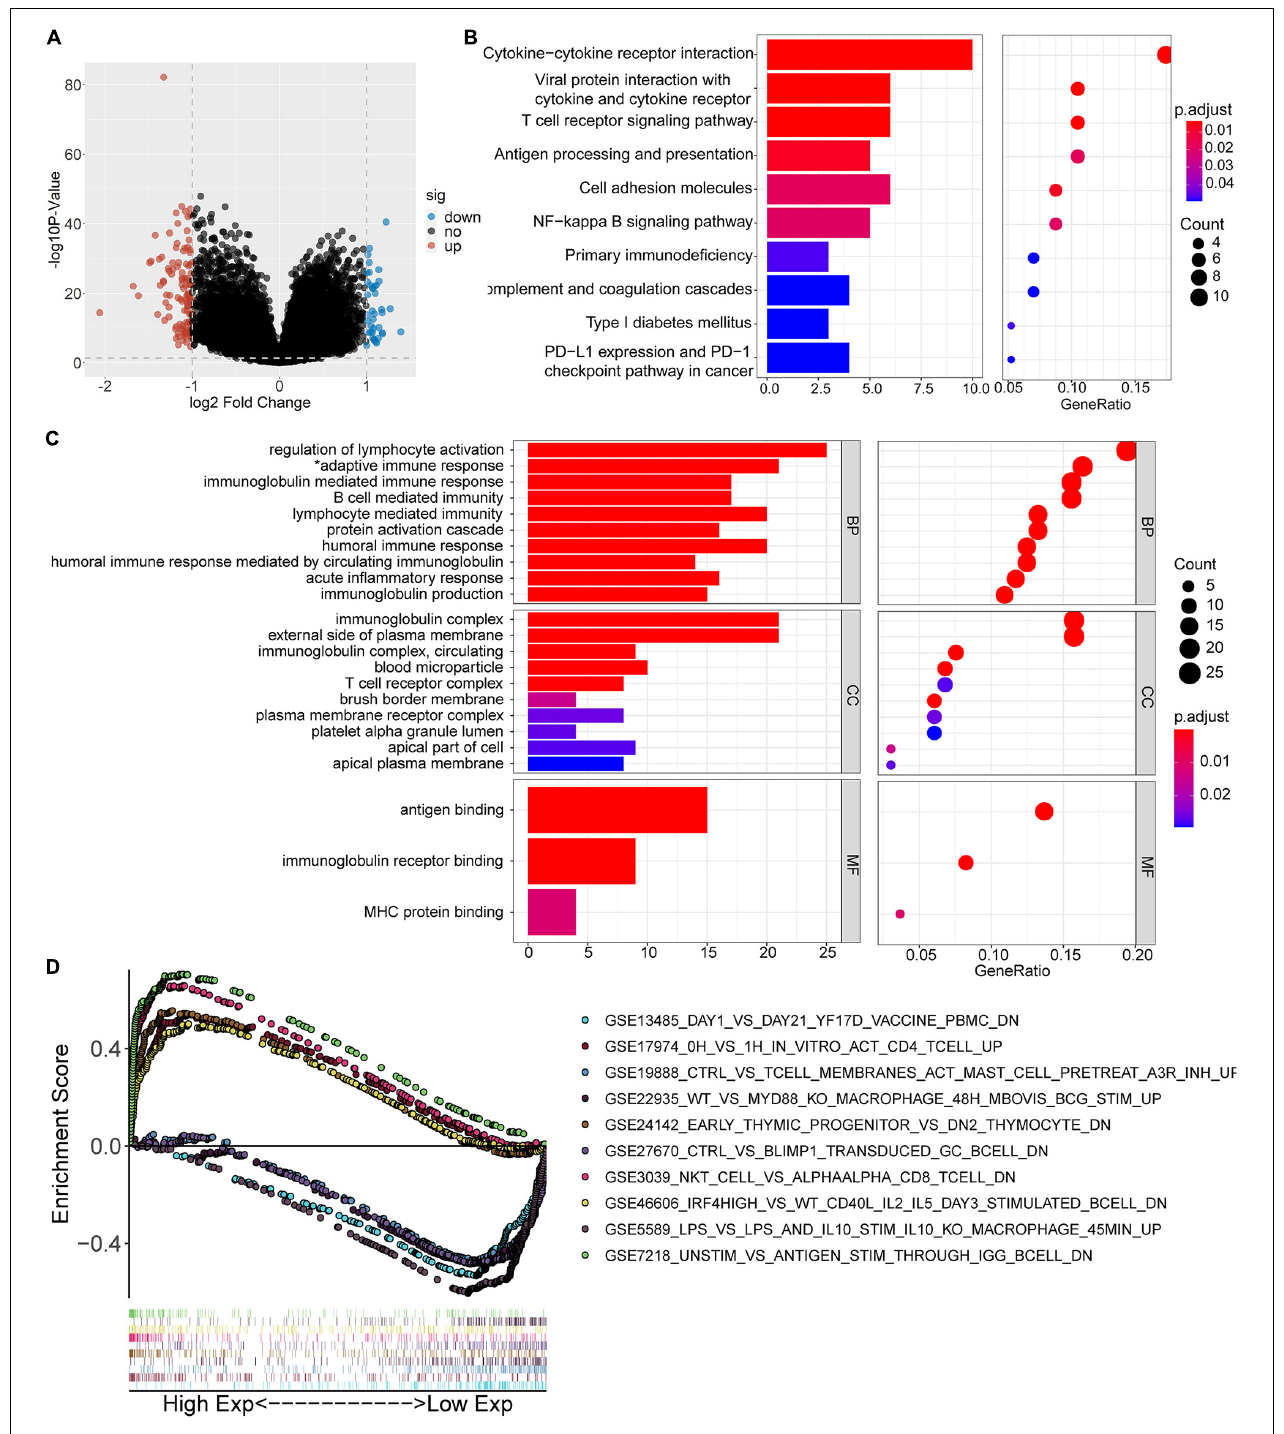
FIGURE 4 | Functional inference of IGFLR1. (A) The volcano plot of DEGs in ccRCC patients with different IGFLR1 expression level. “down” means down-regulated DEGs; “up” means up-regulated DEGs; “no” means the difference was not statistically significant. (B) KEGG analysis of 152 DEGs. (C) GO analysis of 152 DEGs (*adaptive immune response based on somatic recombination of immune receptors built from immunoglobulin SUPERFAMILY domains). (D) The top 5 immunologic signature gene sets in IGFLR1 high expression group and low expression group, respectively.